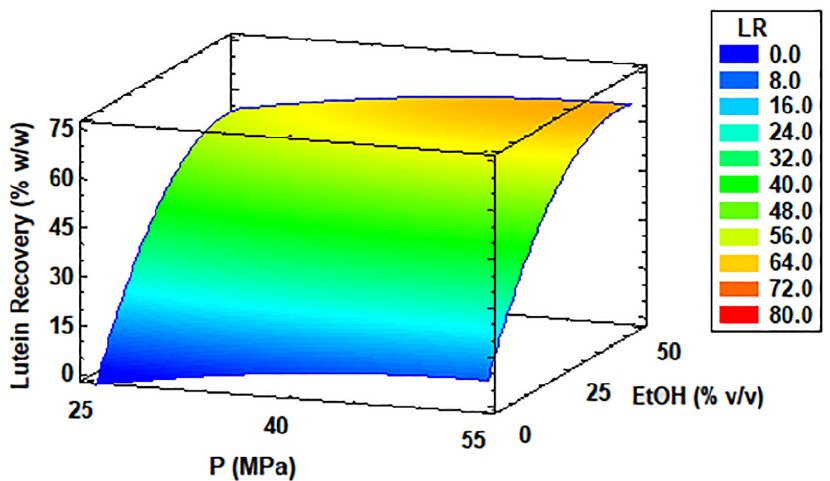
Figure 5. Response surface curve of the combined effects of temperature (30–70 ◦ C), pressure (25–55 MPa), and ethanol as co-solvent (0–50% v / v ) on lutein recovery (LR) from Coccomyxa onubensis . Response surface curves were drawn from the viewpoint of the optimal temperature (70 ◦ C). Abbreviation: temperature (T), pressure (P), and ethanol as co-solvent (EtOH). Compared with conventional extractions, supercritical fluid as green extraction has